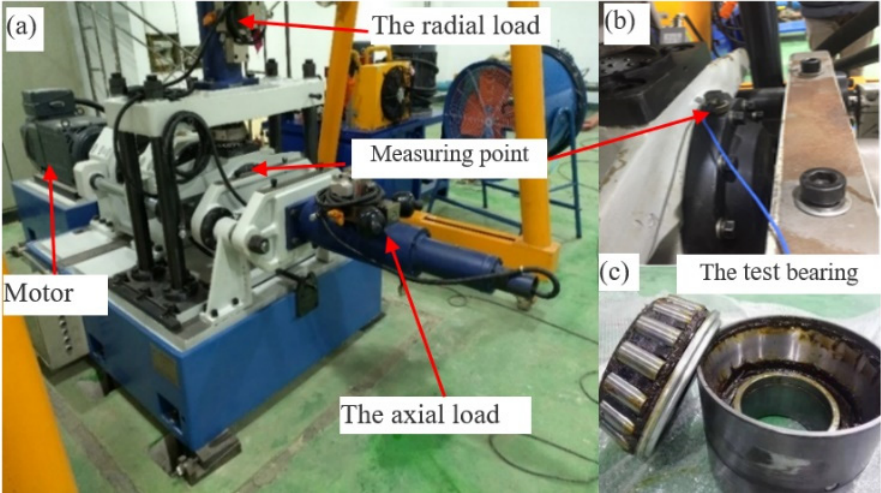
Figure 8. ( a ) high-speed train wheelset bearing test bench; ( b ) local expanded test point; ( c ) test bearing. Table 2. Parameters of the bearing.